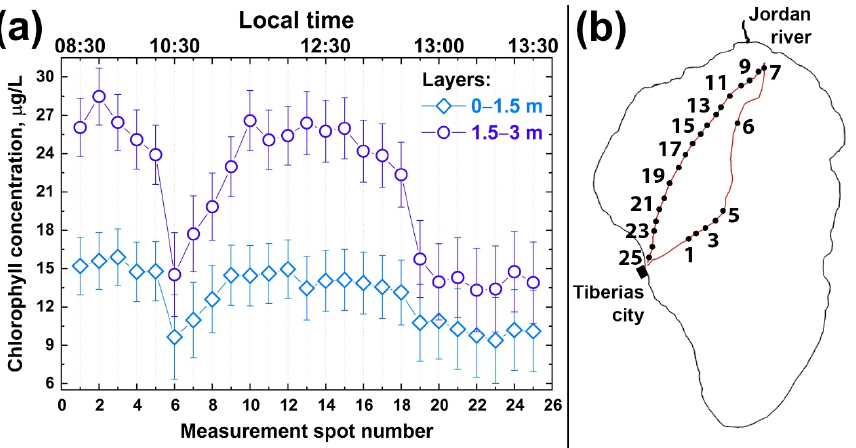
Figure 8. ( a ) Chlorophyll- a concentration profiles in Lake Kinneret at two depth intervals: 0–1.5 m (rhombuses) and 1.5–3 m (circles), measured by fluorescence LiDAR on 8 October 2018 in different spots along the trimaran route shown on the panel ( b ). Measurement spot numbers on the panel ( a ) correspond to ones on the panel ( b ). It can be seen from Figure 8a that the chlorophyll concentration was rather high at depths of up to 3 m near the Tiberias beach (points 1–4 in Figure 8b). Near the Ecoraft